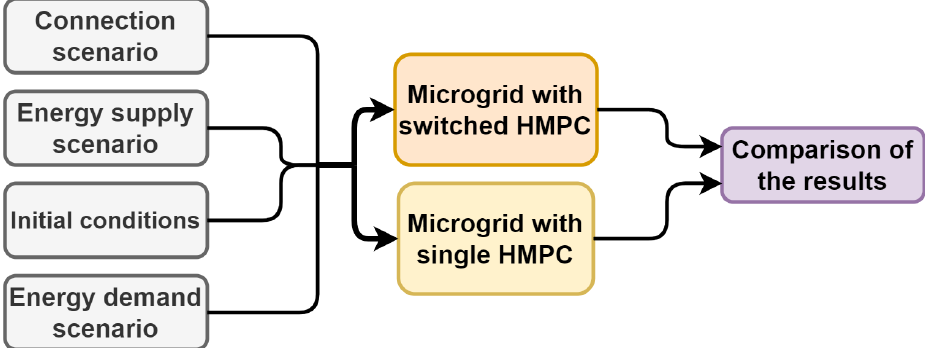
Figure 6. Diagram showing the methodology used to compare switched and non-switched HMPC per-